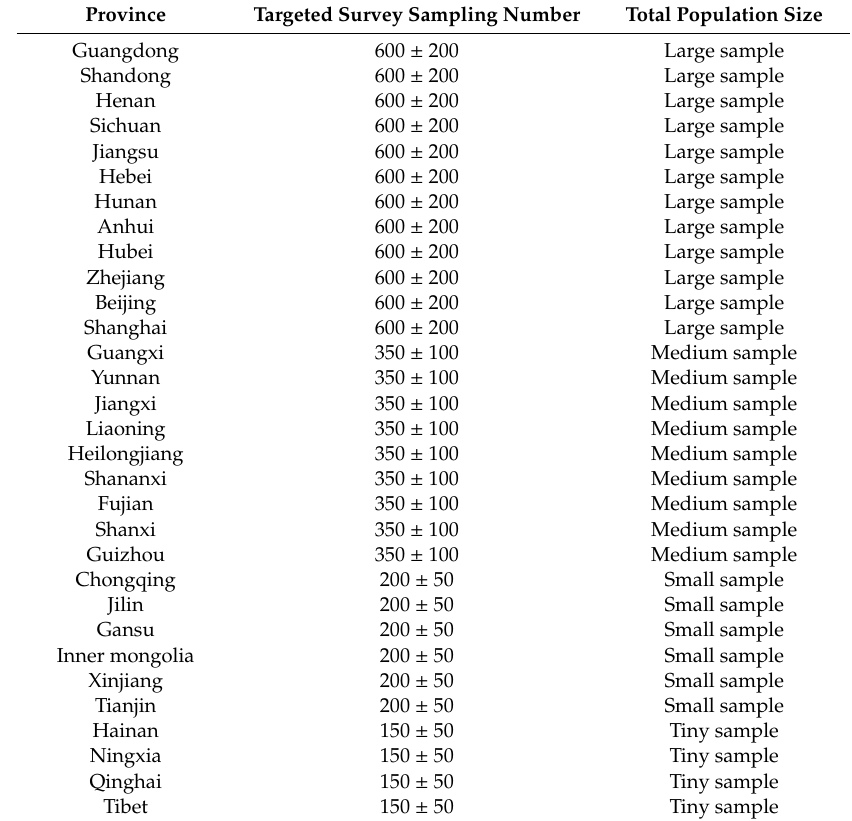
Table A1. Targeted survey sampling number per each province among Chinese residents aged 18 years